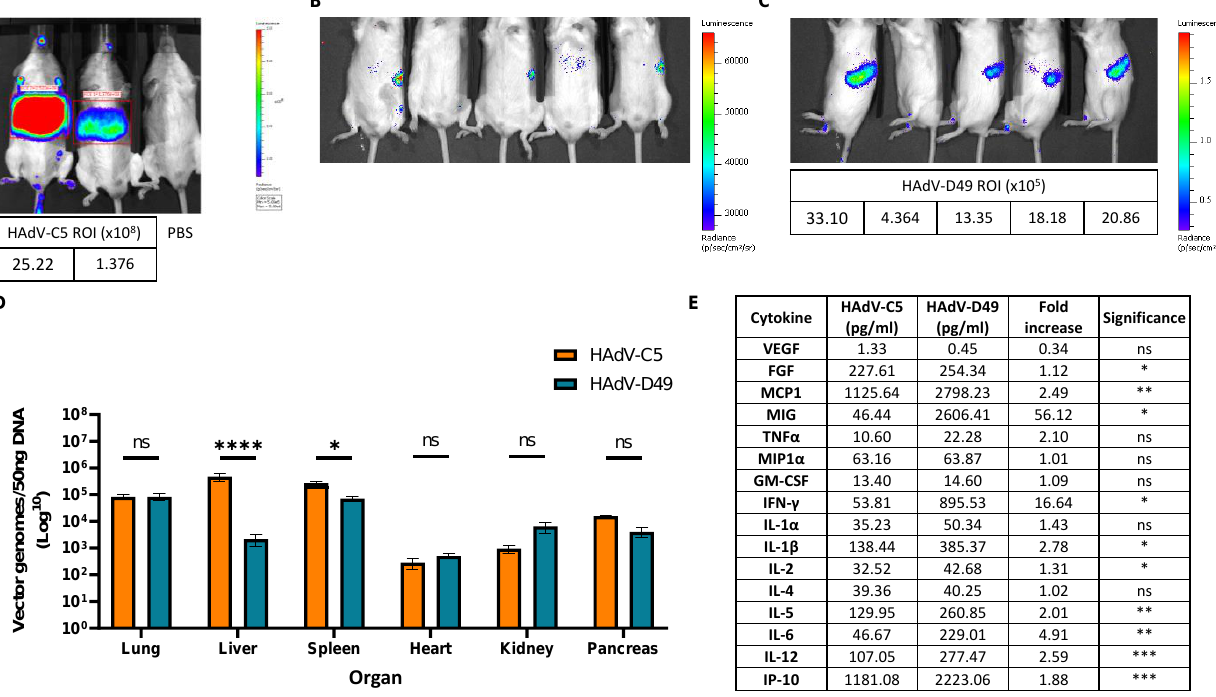
Figure 2. In vivo biodistribution analysis of HAdV-D49 vectors compared to HAdV-C5 vectors. IVIS imaging system used for in vivo quantification of ( A ) HAdV-C5 (ROI ×10 8 ) liver transduction with PBS control; ( B ) IVIS images of HAdV-D49 (shown as Ad49) transduction with mice imaged on their backs, and ( C ) IVIS images of HAdV-D49 (Ad49) transduction when mice are imaged on their sides. Uptake in the spleen was quantified using ROI (×10 5 ). ( D ) Quantification of biodistribution using a dose of 1 × 10 11 virus particles. qPCR to evaluate vector genomes in the lung, liver, spleen, heart, kidney, and pancreas. ( E ) Cytokine concentrations, gauged by Luminex 20-plex cytokine analysis in mouse plasma after HAdV-C5 (Ad5) or HAdV-D49 (Ad49) administration (shown as pg/mL), and demonstrated as fold increase of HAdV-D49 in comparison to HAdV-C5. Individual plots are shown in Figure S1. ns, not statistically significant, p > 0.05; *, p < 0.05; ** p < 0.01; ***, p < 0.001; ****, p < 0.0001.